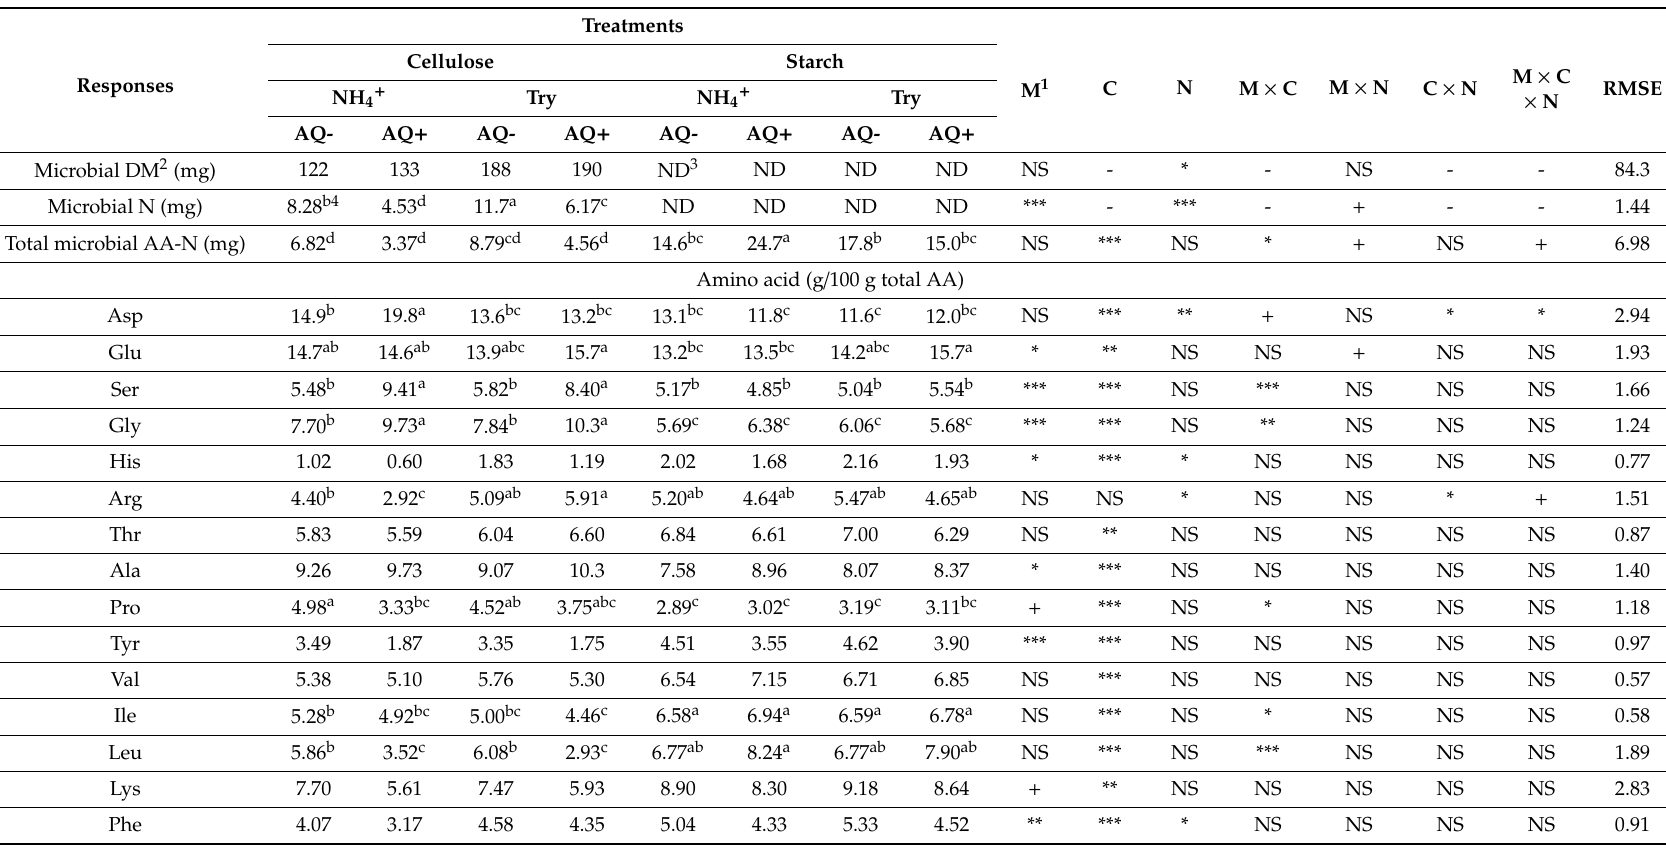
Table 2. E ff ects of the addition of 9, 10-anthraquinone to rumen batch cultures incubated with cellulose or starch as carbon and energy sources and ammonium or trypticase as sources of nitrogen on microbial biomass production and amino acidic